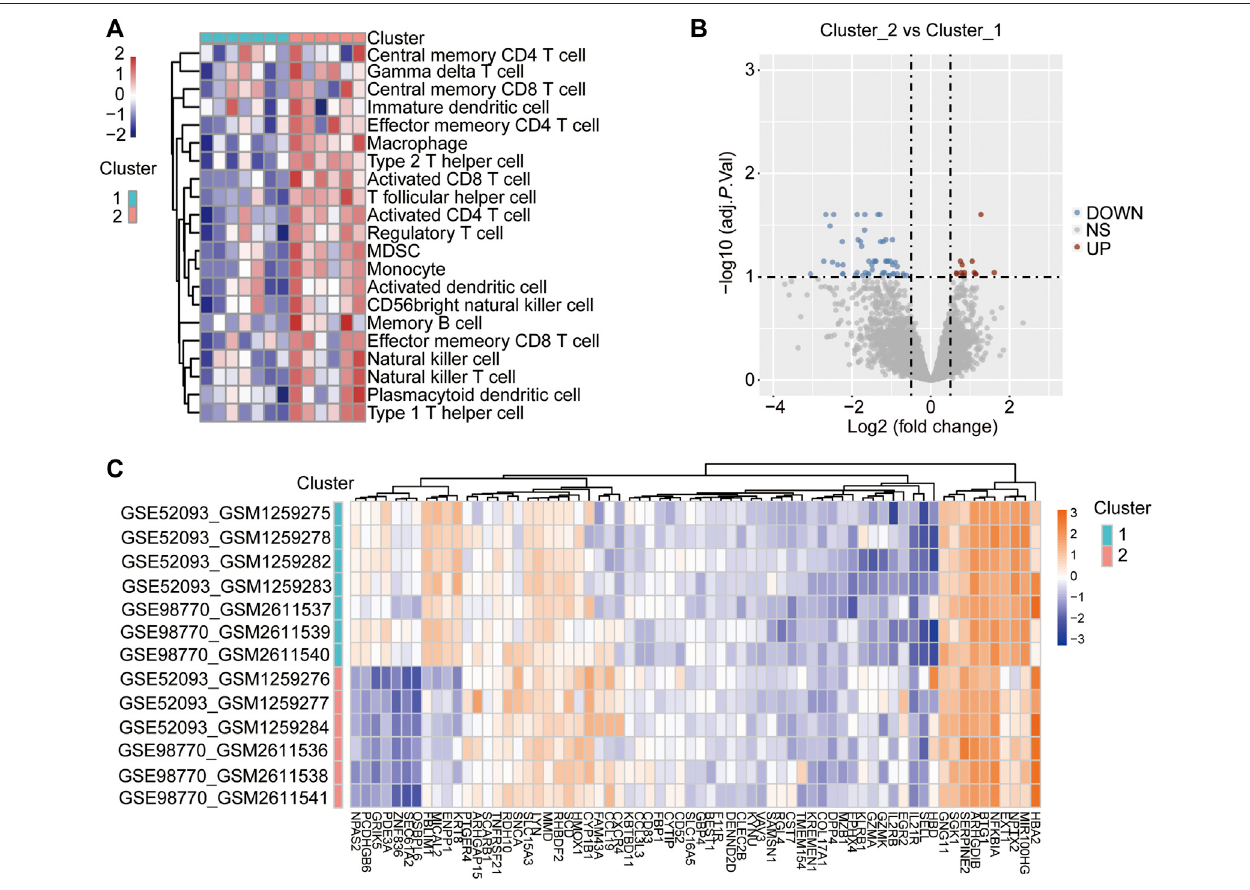
FIGURE 4 | Identi fi cation of DEGs between the two immune-related clusters. (A) Heatmap shows the difference in immune cell in fi ltration between the different immune-relatedclustersviassGSEA.Theredrepresentsactivatedimmunecellsandbluerepresentssuppressedimmunecellsincluster2. (B) VolcanoPlotshowingthe DEGs in the cluster 2 vs. cluster 1 subgroups. The red dots represent up-regulated genes, the blue dots represent down-regulated genes, and the gray dots represent genes with no signi fi cant difference. DEGs were identi fi ed with the threshold of adjust p -value < 0.05 and Fold change > 2. (C) Heatmap showing the DEGs in the cluster 2 vs. cluster 1 subgroups. The red represents up-regulated genes, while the blue represents down-regulated genes.